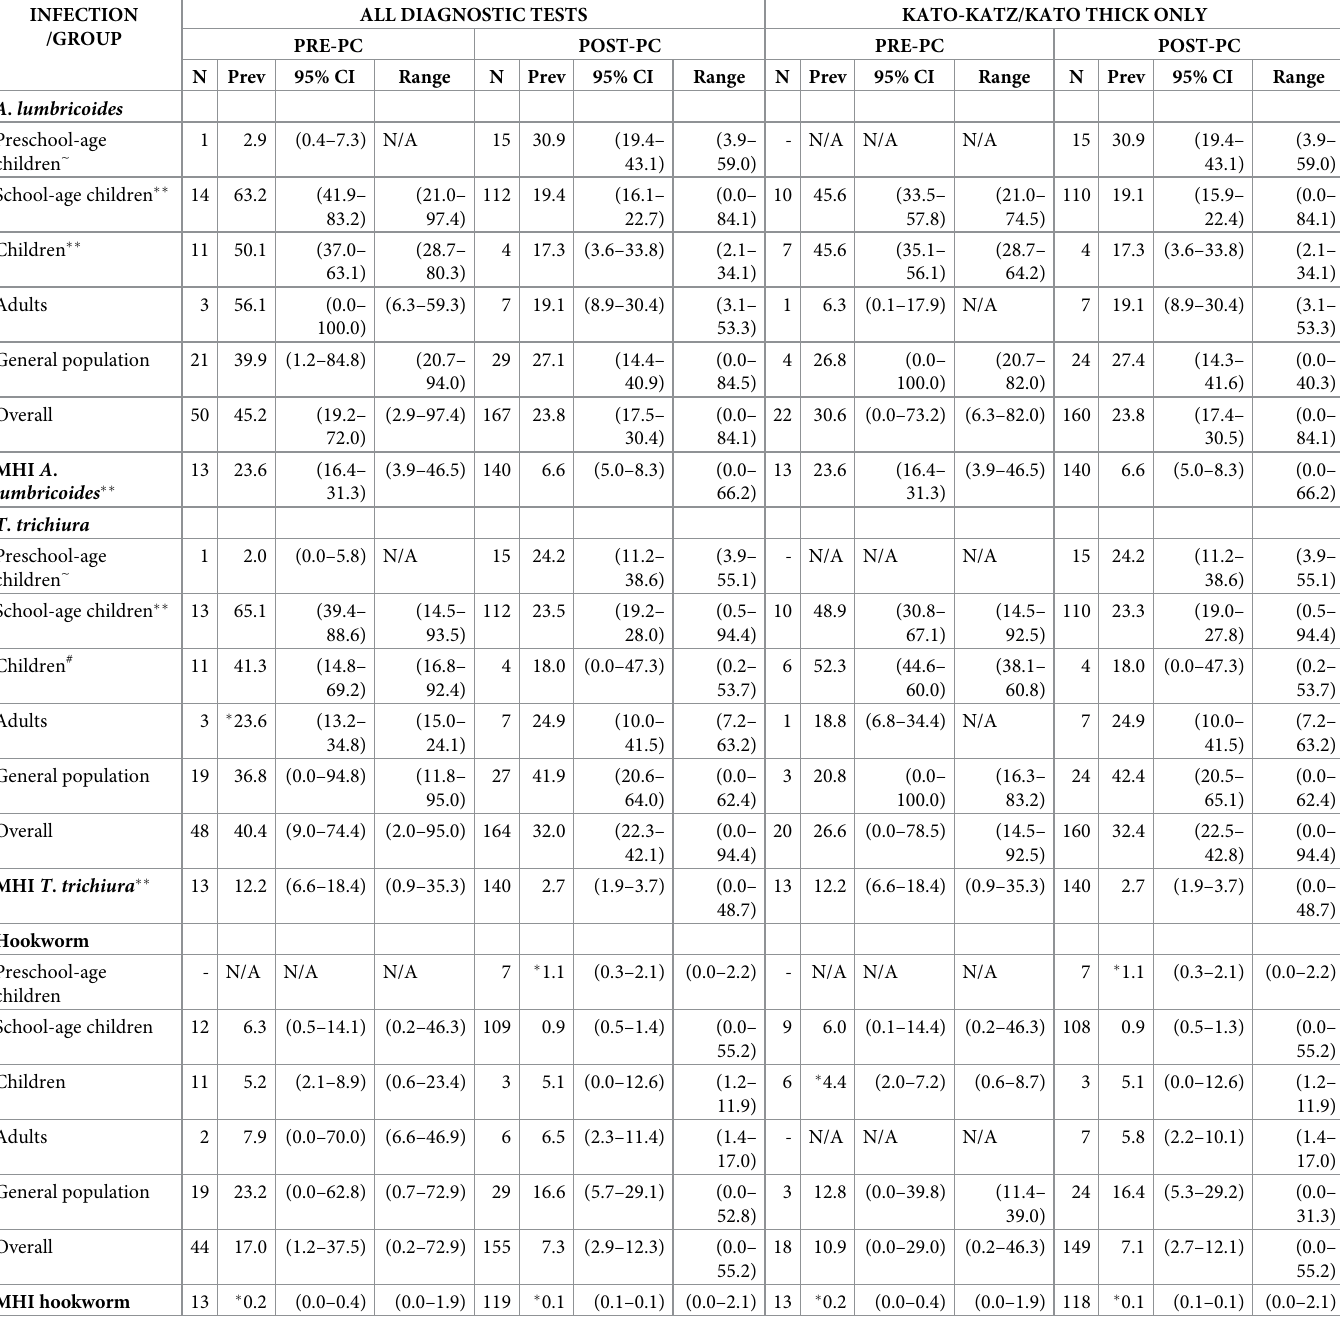
Table 2. Meta-analyses of prevalence of A . lumbricoides , T . trichiura , hookworm by preventive chemotherapy status and population